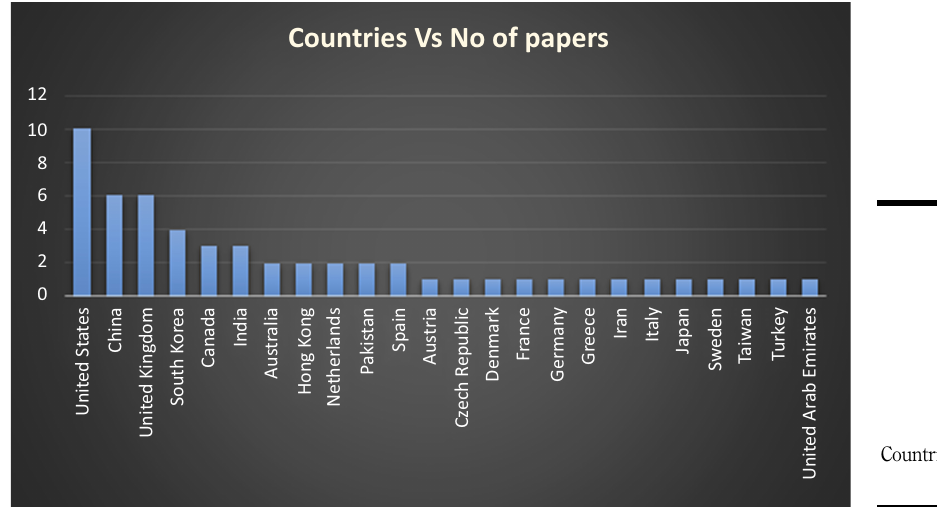
Figure 4. Countries of published